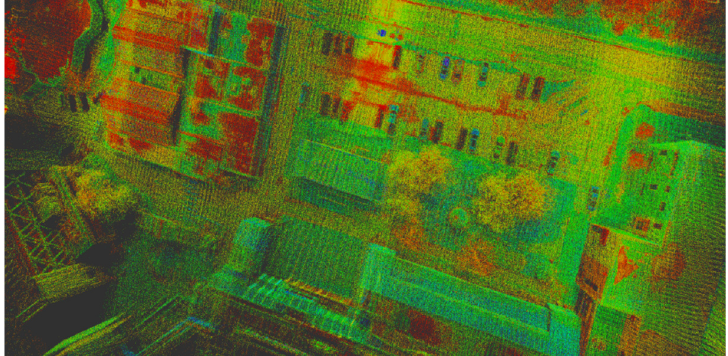
Figure 9. LiDAR SLAM trajectory for the first test site.